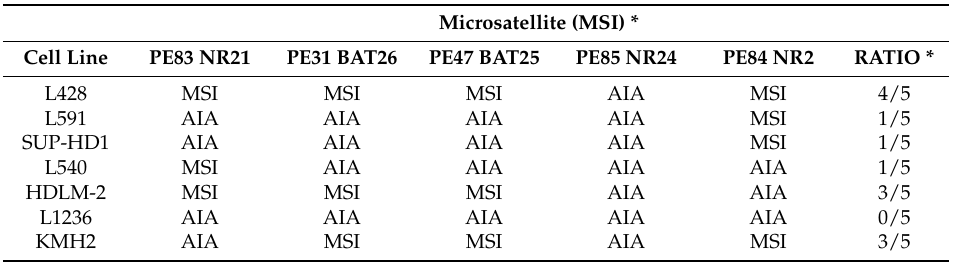
Table 1. The status of the five quasi-monomorphic mononucleotide repeat markers used to study Microsatellite Instability (MSI) in HL cell